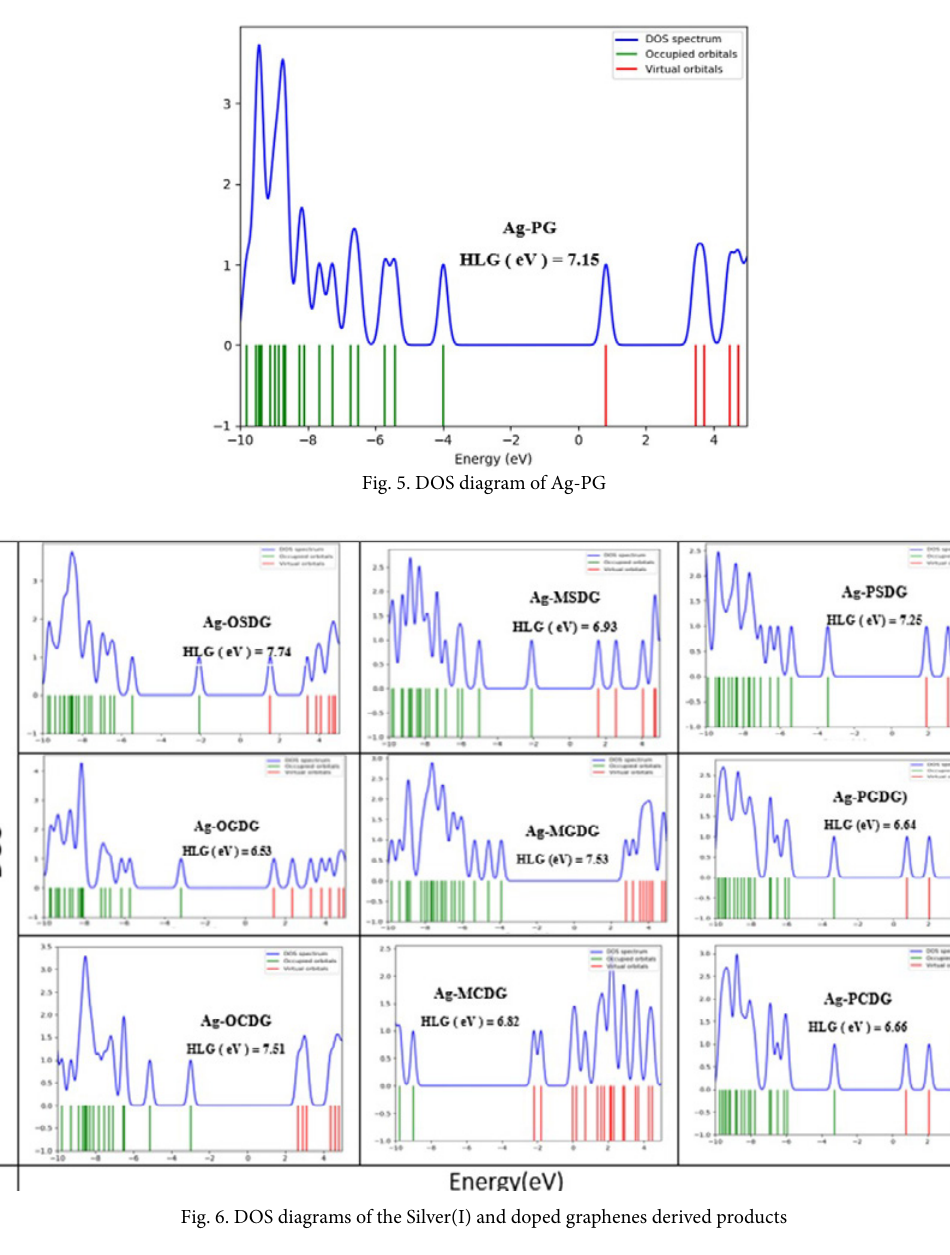
Fig. 6. DOS diagrams of the Silver(I) and doped graphenes derived product s